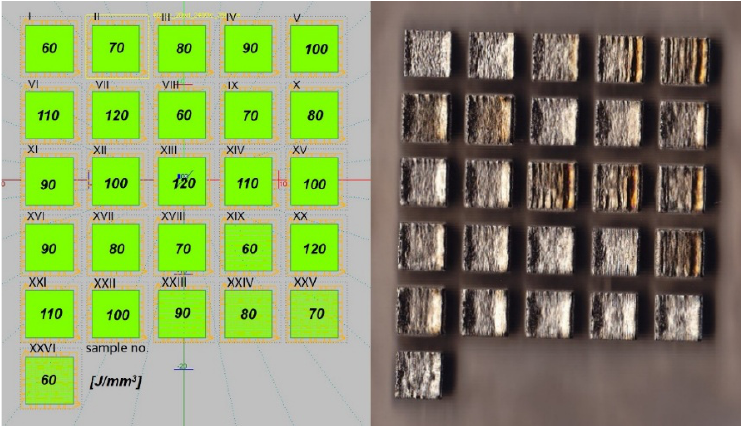
Figure 2. Set of 26 cubic samples prepared for process parameters optimization on a Realizer SLM50 machine. Samples’ numbering and energy densities (J/mm 3 ) delivered to the material (left side). Samples’ top surfaces after fabrication (right side).